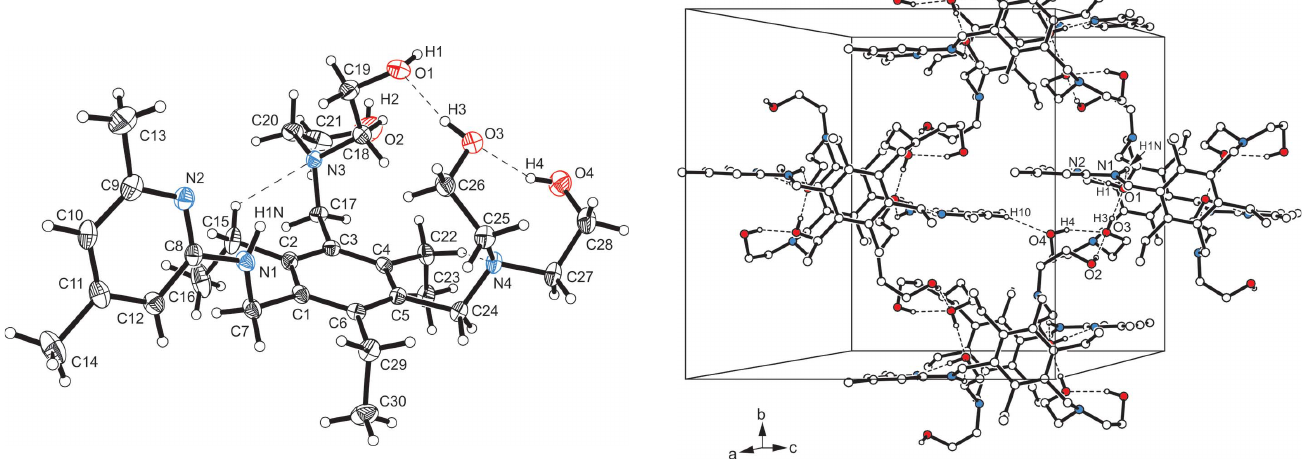
Figure 3 Packing excerpt of the title compound with numbering of coordinating atoms. Oxygen atoms are displayed as red, nitrogen atoms as blue circles. Hydrogen atoms excluded from intermolecular interactions are omitted for clarity. Hydrogen bonds are shown as broken